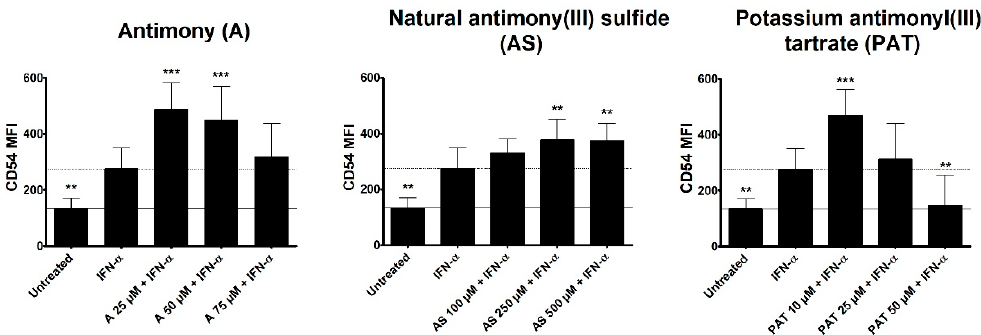
Figure 5. Effect of ACs on CD54 expression on THP-1 cells. THP-1 cells were pre-treated with either A, AS or PAT for 2 h before stimulation with 10 ng/mL IFN- α for 24 h. Afterwards, expression was analyzed by flow cytometry after staining CD54 with a specific antibody coupled to the fluorophore APC. Results are shown as mean fluorescence intensity (MFI) ± SD of 4 independent experiments. Statistical analysis was performed using one-way ANOVA with Newman–Keuls post-test comparing the samples to Pso stimulation. * p ≤ 0.05, ** p ≤ 0.01, *** p ≤ 0.001.